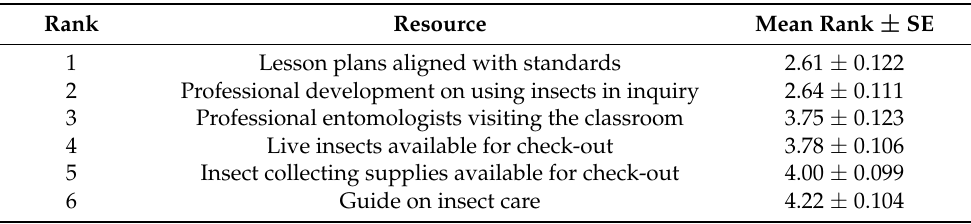
Table 2. Teacher rankings of preferred